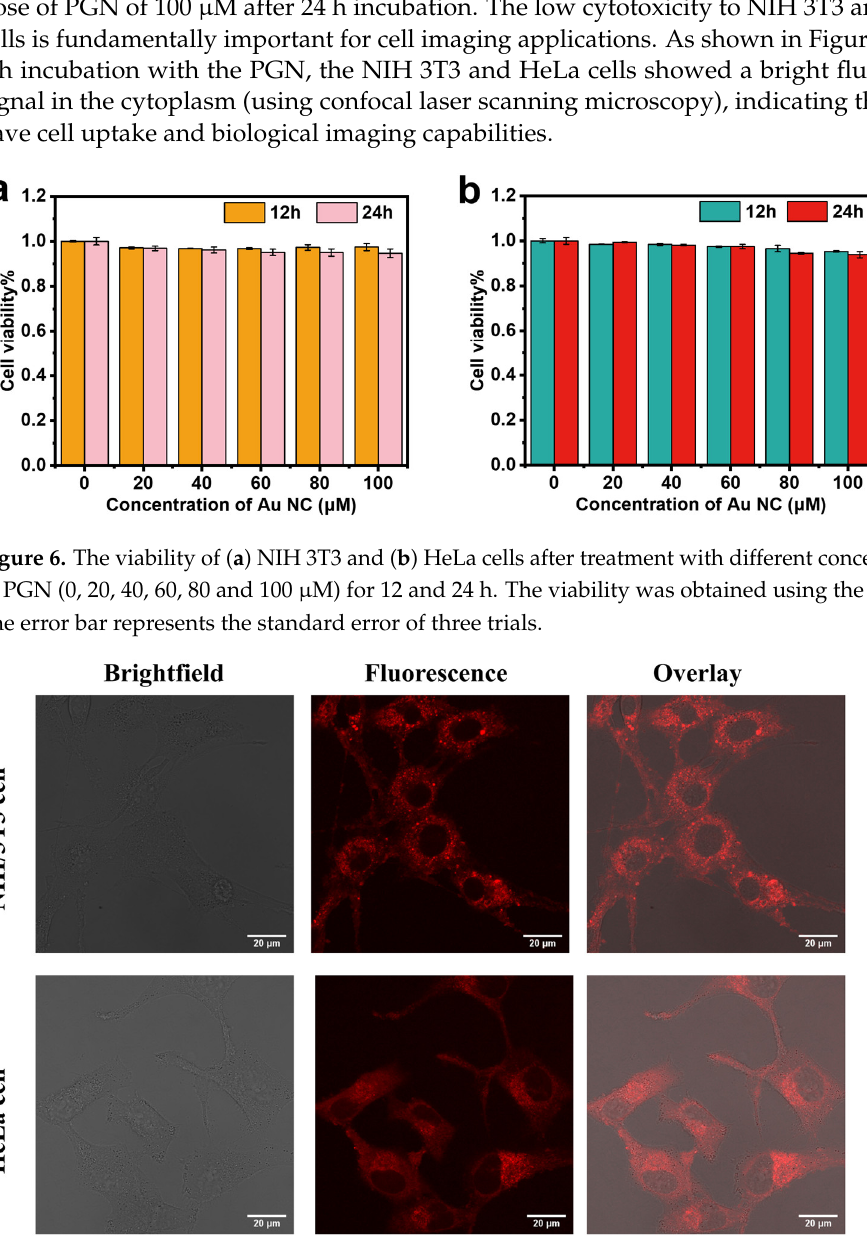
Figure 7. Fluorescence imaging of HeLa cells after incubation with PGN (60 µ M) for 2 h. Scale bar = 20 µ m.